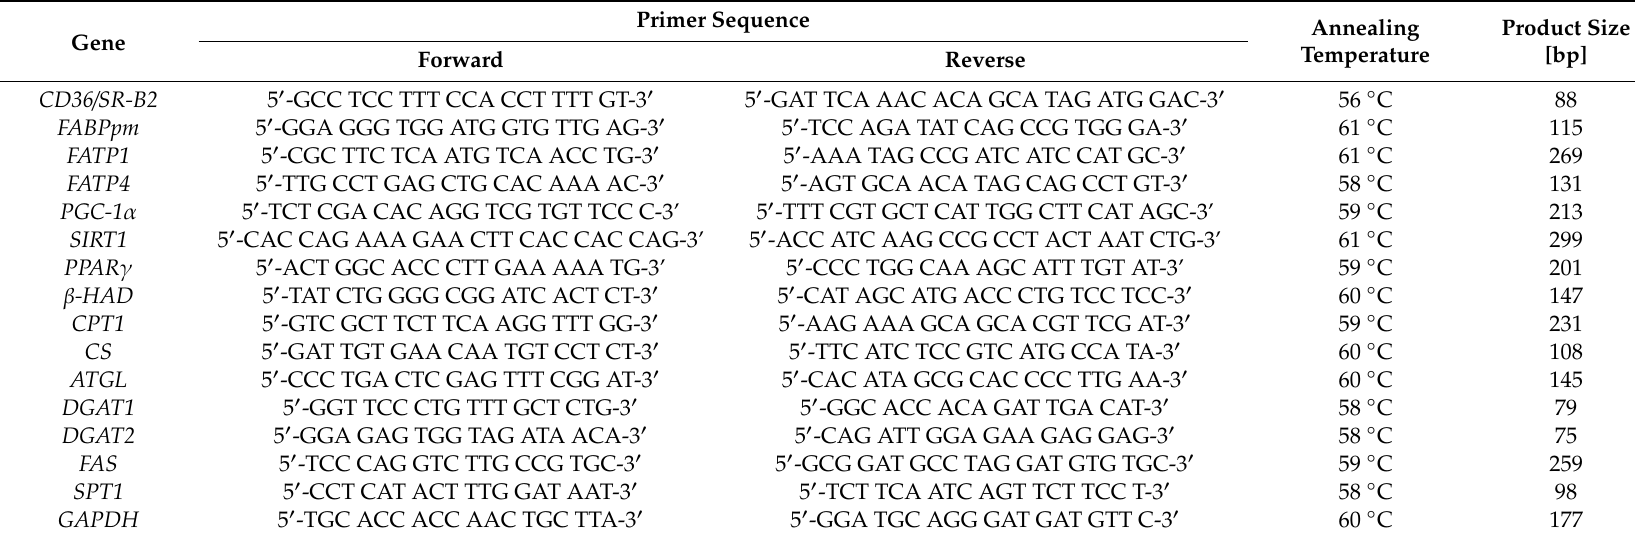
Table A4. Annealing temperature and specific primer sequences for target genes in real-time PCR